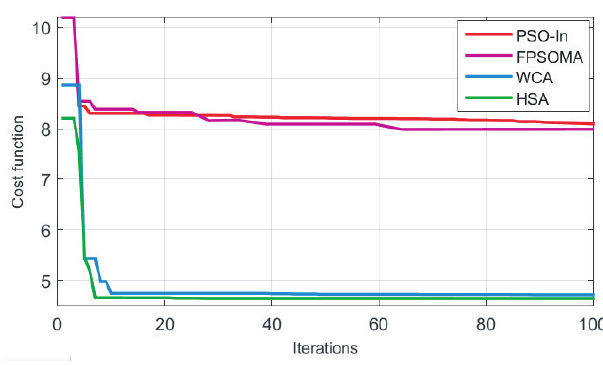
Figure 16. Convergence curves of Problem (32).